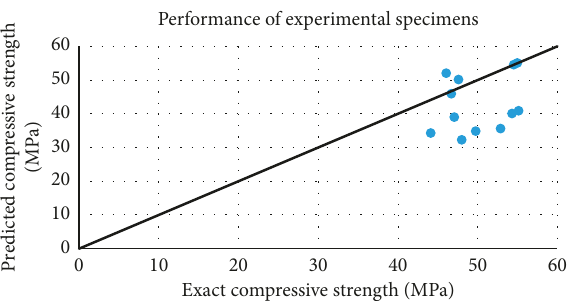
Figure 14: Comparison of exact compressive strength with CSPNN-predicted compressive strength for the 12 experimental concrete mixtures.